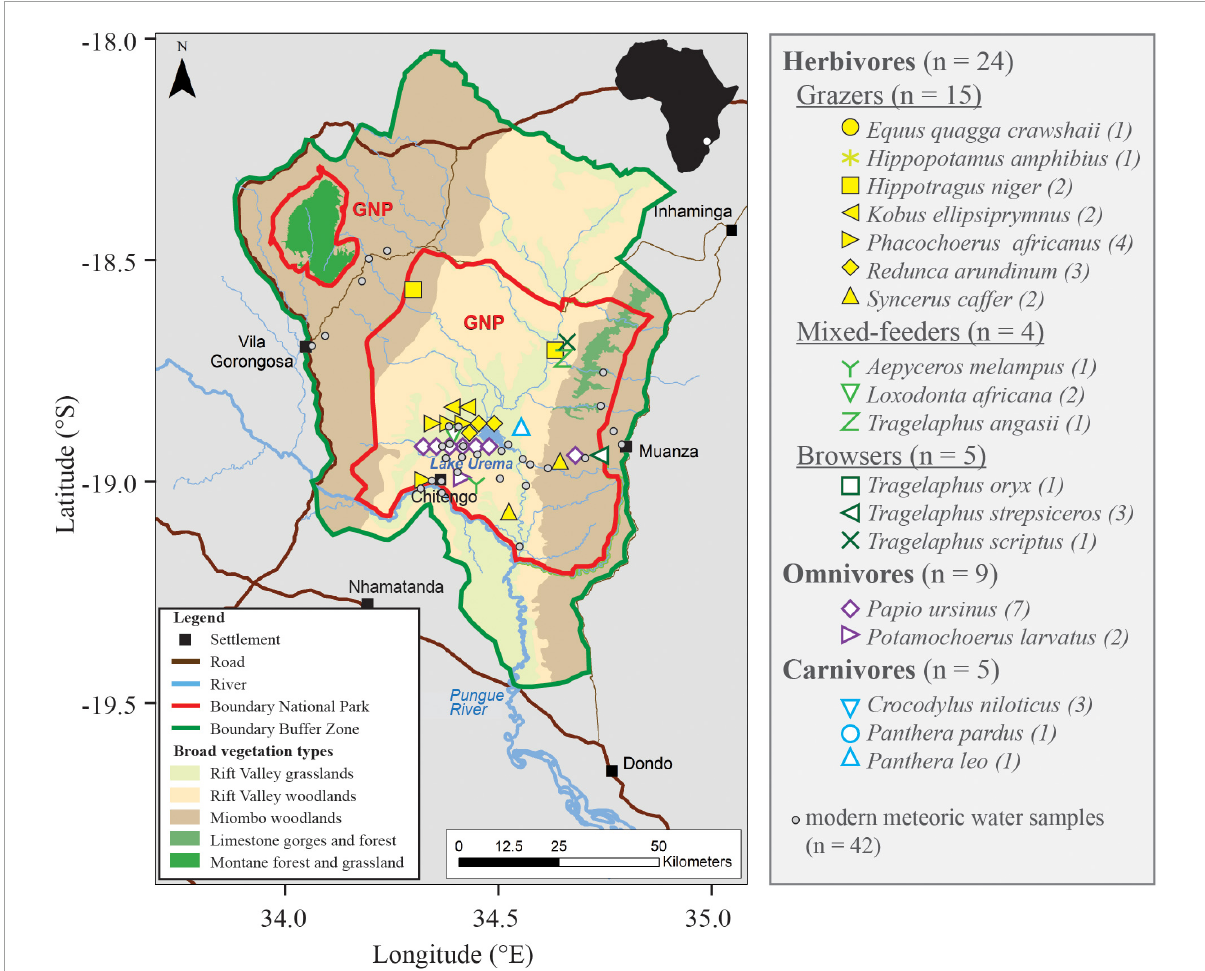
FIGURE2 Map of Gorongosa National Park (red outline) and the Buffer Zone (green outline) indicating main vegetation types (modified after Stalmans and Beilfuss, 2008) with faunal and meteoric water collection sites. GPS coordinates for fauna specimens and water samples can be found in Supplementary Tables 1 , 2 . Note that the exact location of nine faunal specimens is not known, because they were collected before the start of the PPPG, but all specimens are from inside the park or Buffer Zone. A black line drawing of Africa shows the position of GNP (white